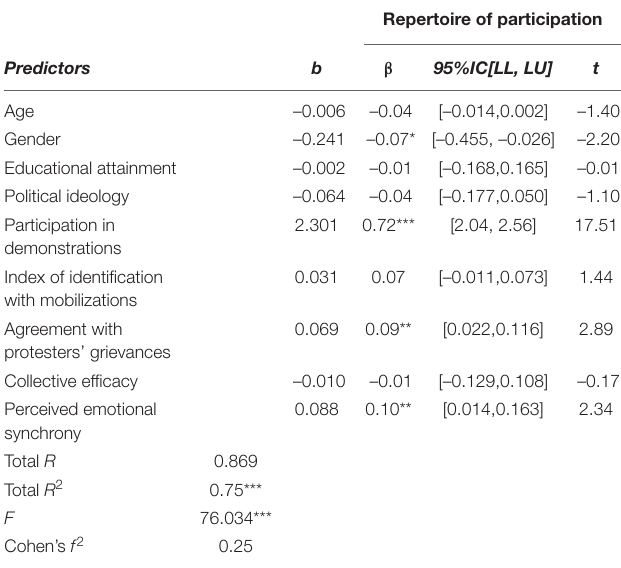
TABLE 3 | Multiple regression analyses predicting collective action indicator by collective identity-related variables and collective effervescence.